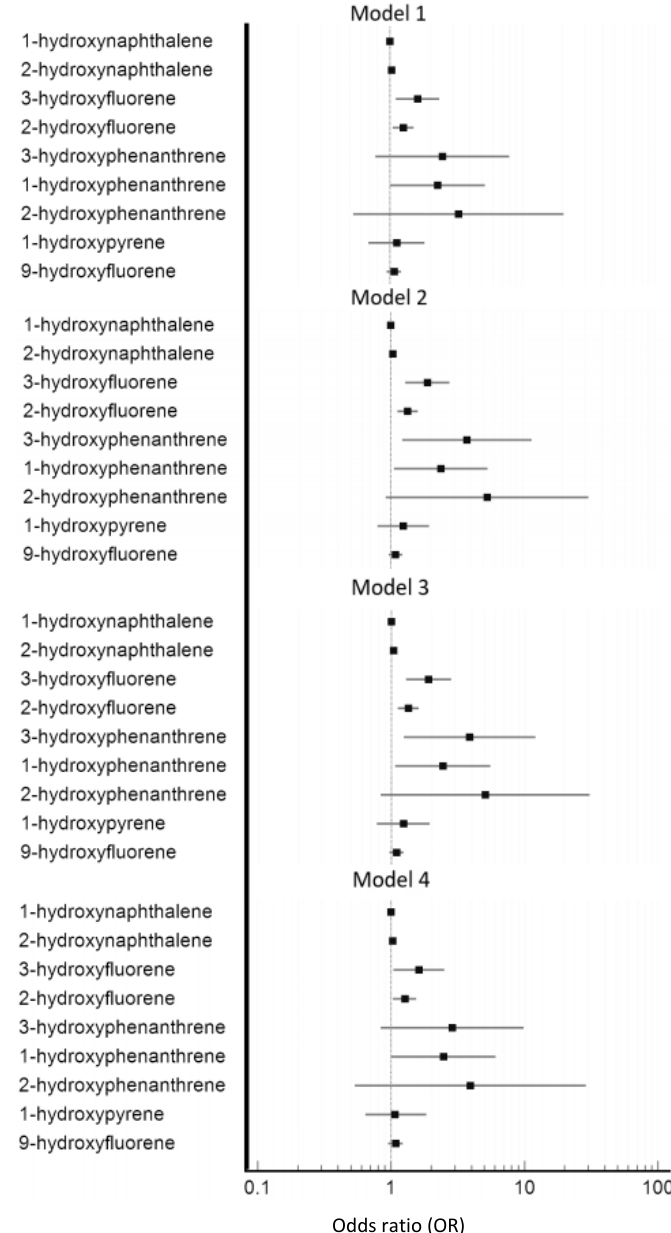
Figure 1. Forest plot of association between PAHs and diarrhea.